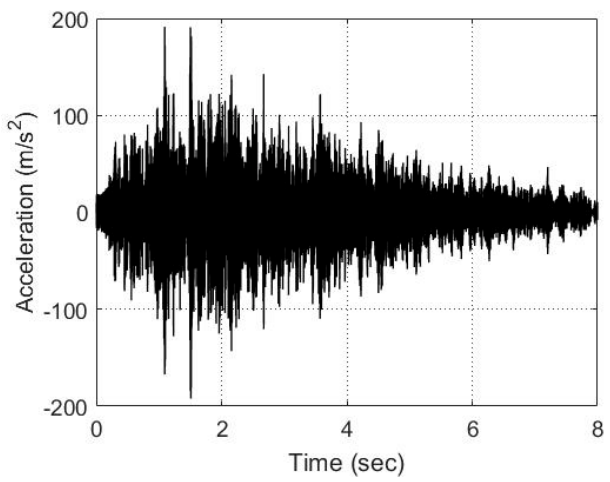
Figure 18. Acceleration response signal of the first DOF measurement. Table 6. Modal parameter identification result of free beam experiment.